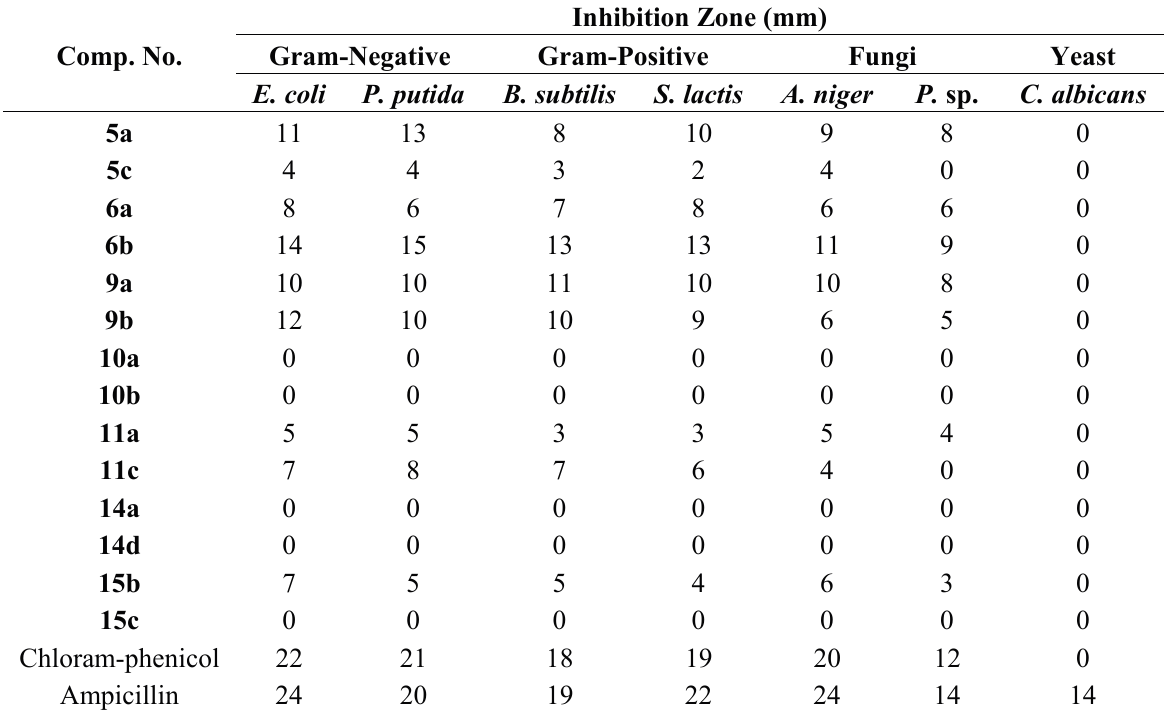
Table 2. Antimicrobial activities of the newly synthesized